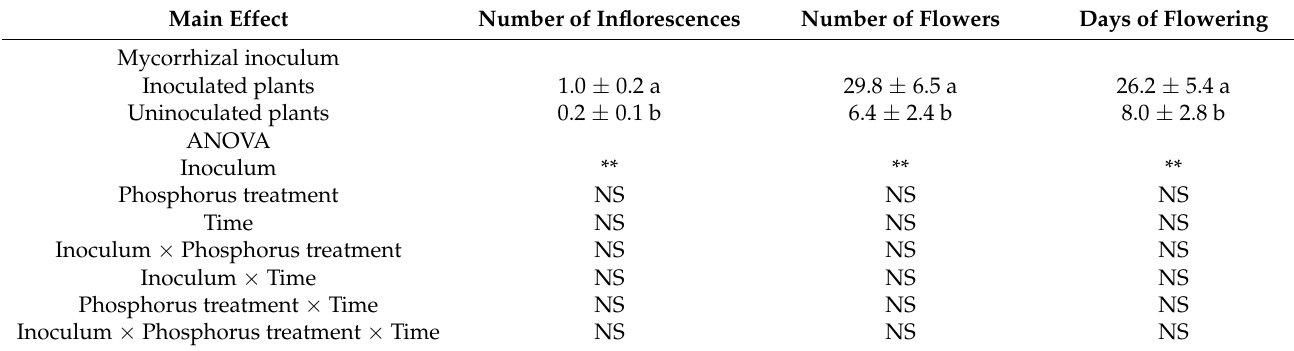
Table 4. The average number of inflorescences, number of flowers and days of flowering ( ± standard error) (n = 20) of inoculated and uninoculated Ajania